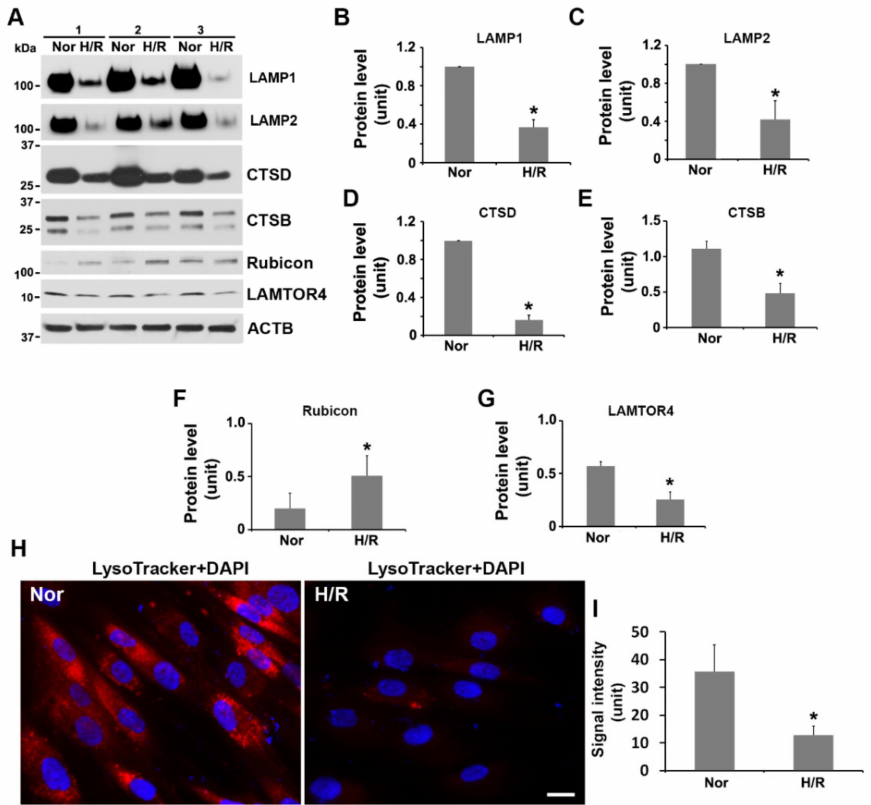
Figure 3. Exposure to H/R impairs lysosomal integrity and activity and autolysosome formation in PHTs. ( A ) The abundance of lysosomal resident proteins and regulators of autolysosome formation in normoxia (Nor)- and H/R-treated PHTs. ( B – G ) Quantitative analysis of the band intensity of indicated proteins. ( H , I ) LysoTracker staining in normoxia (Nor)- and H/R-treated PHTs ( H ) and quantitative data for comparison of LysoTracker signal intensity between Nor- and H/R-treated cells. The nuclei were stained with DAPI. Data are expressed as mean ± SEM and statistically analyzed by a Student’s t -test ( n = 3, *: p <